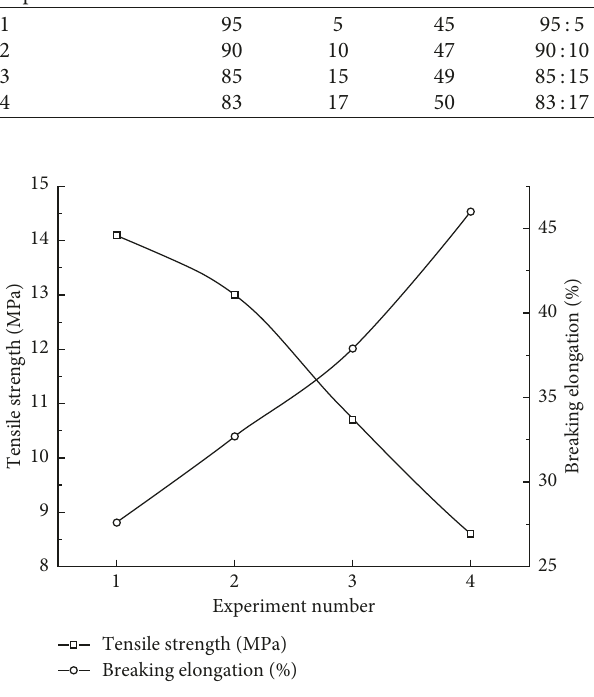
Figure 6: Effect of different ratios of Component A/diluent on tensile properties after 7